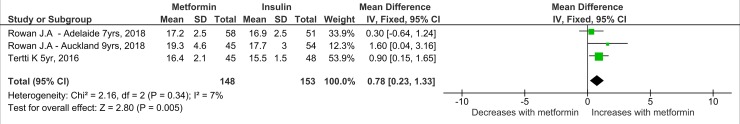
Childhood BMI.Expressed as mean differences (fixed effects model) and 95% CI. IV, mean difference.